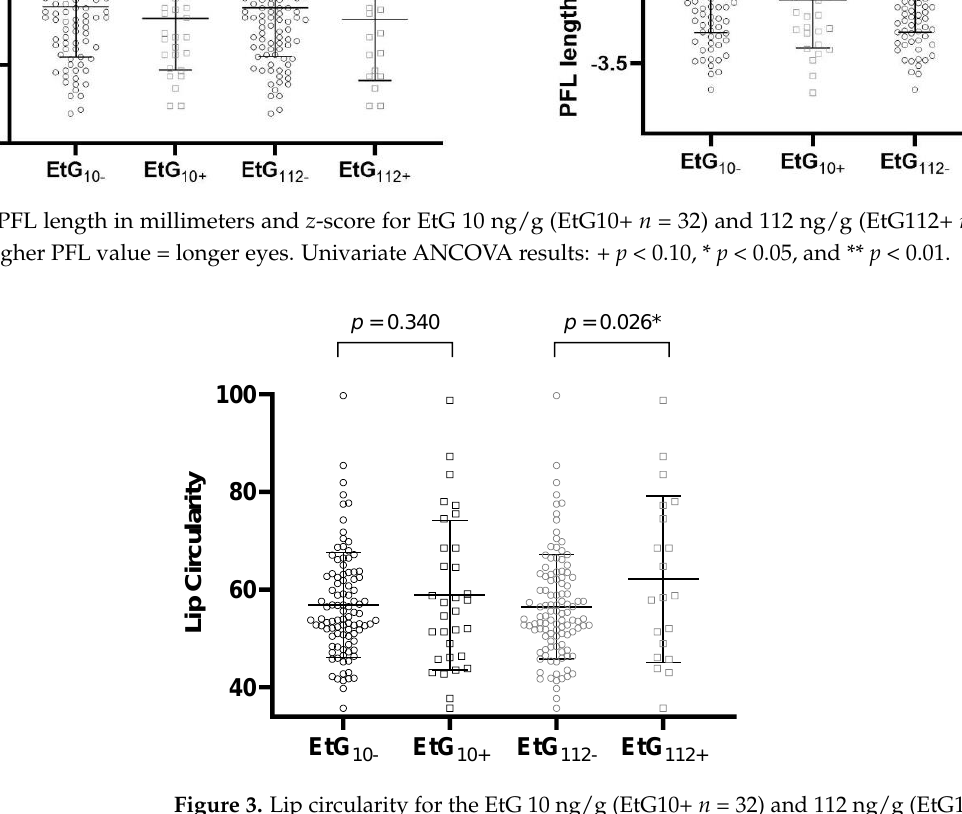
Figure 3. Lip circularity for the EtG 10 ng/g (EtG10+ n = 32) and 112 ng/g (EtG112+ n = 20) cut-offs. Higher lip circularity value = smaller upper lip size. Univariate ANCOVA results: * p <